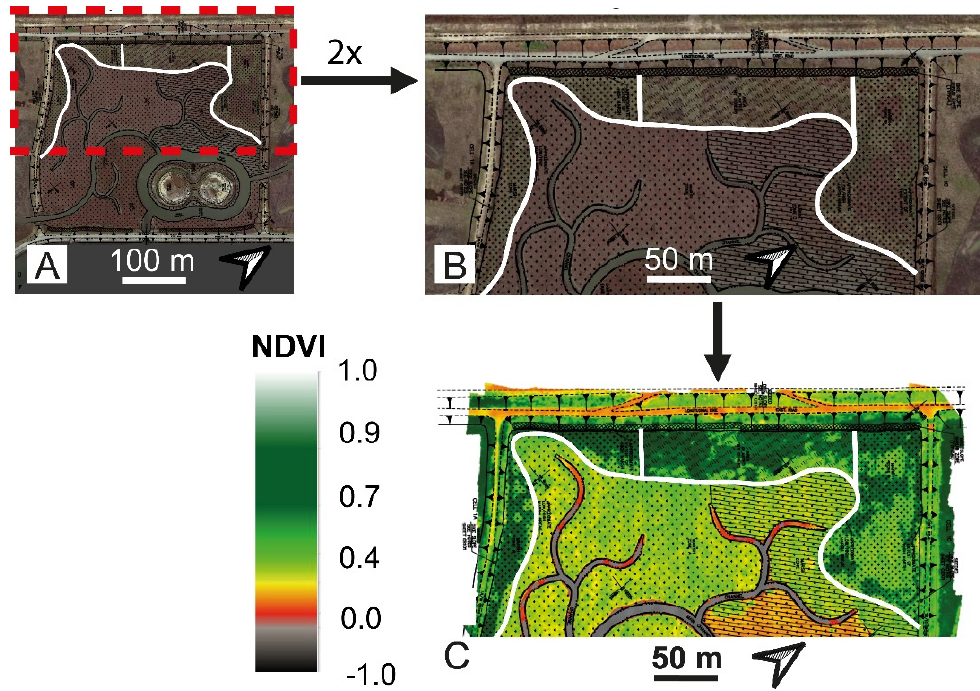
Figure 5. Maps of the initial plant configuration in Cell 1B (( A , B ), and highlighted in the zoomed plot of Figure 1) a georeferenced orthophoto was combined with an NDVI map in the month of October 2019 ( C ). The white continuous line displays the original boundary between the S. pumilus (high marsh) and S. alterniflora (low marsh). Light green in plot C shows an invasion of the S. alterniflora into the high marsh zone of Cell 1B, reflected as a dark